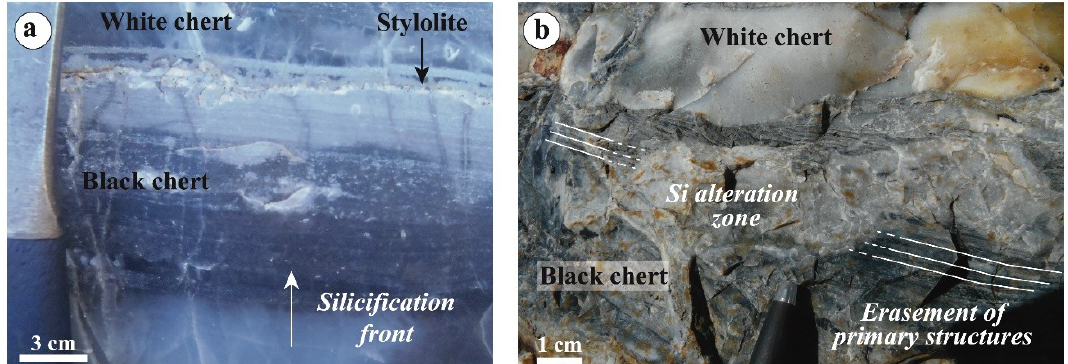
Figure 5. Silicification and fluid circulation features within the Buck Reef cherts. ( a ) Thinly laminated, black to light grey chert affected by diffuse silica migration, perpendicular the to bedding: disappearance of internal structures behind a white, semi-translucent color. ( b ) Black chert with internal laminations (highlighted in white) is partially erased by a well-developed silica alteration zone.